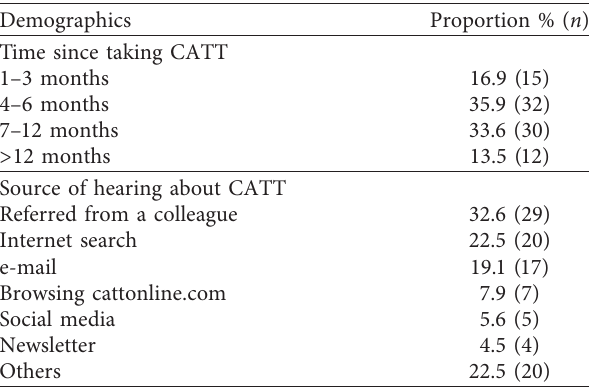
Table 3: QA/QI respondents’ demographics ( n �